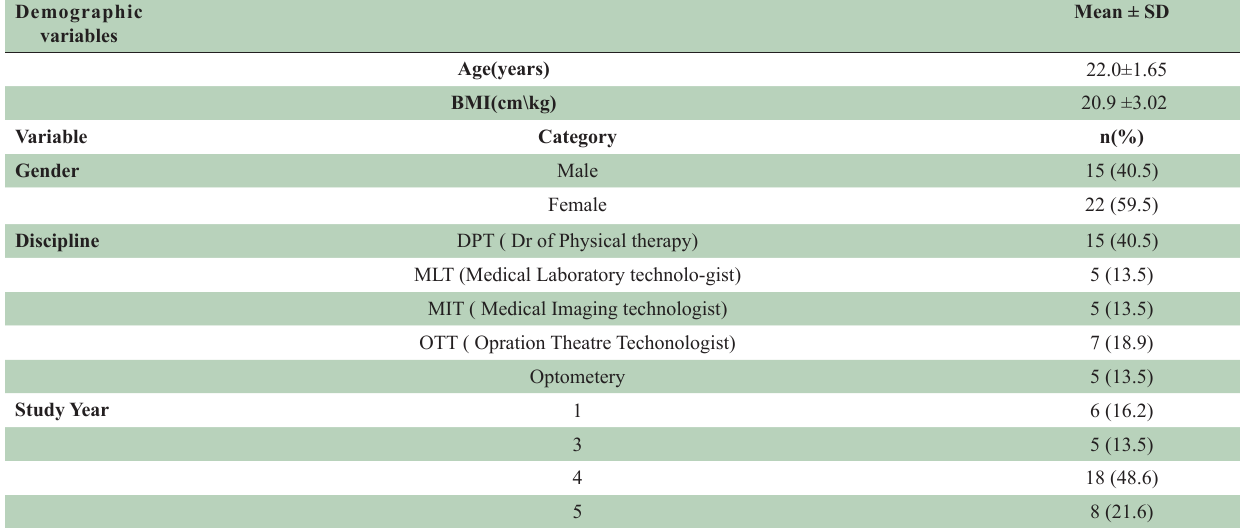
Table-I: Demographic variables of Participants.